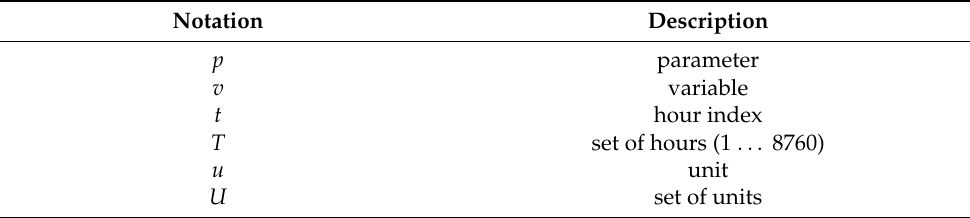
Table A1. Notation used in the optimization model